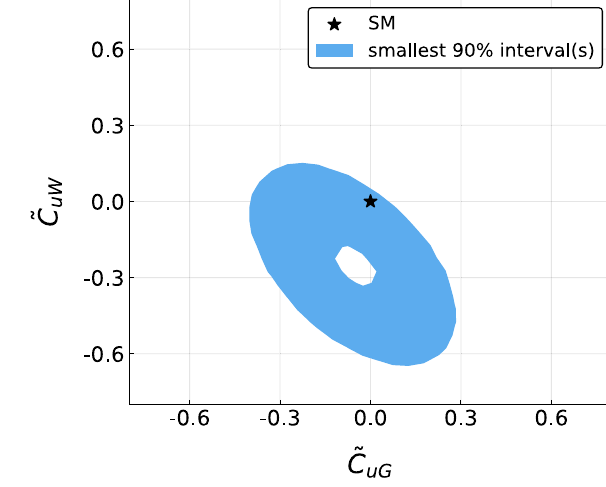
Fig. 9 Posterior probability distributions for the fit of all three Wilson coefficients using only the measurements of σ( t ¯ t γ) . Shown are (left) the marginalized posterior probability distribution of ˜ C uB together with the corresponding smallest interval containing 90% of the probability